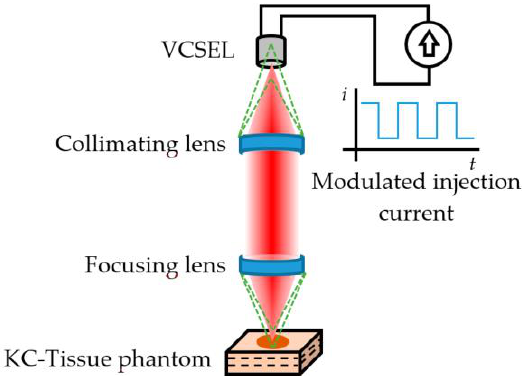
Figure 5. Confocal Laser Feedback Tomography as proposed by Mowla et al. [90]. The green dashed lines represent the out-of-focus reflections that are eliminated by the aperture of the 850 nm VCSEL acting as source/detector. The injection current was modulated to generate the interferometric fringes from the three-layer KC-Tissue